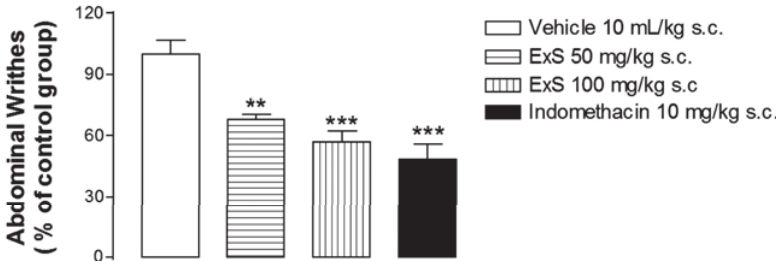
Figure 1 - Effect of Streptoverticillium sp. extract (ExS 50 and 100 mg/kg, s.c.) on the number of acetic acid-induced abdominal writhes in mice. The vertical bars indicate the mean ± SEM, expressed in relative percentage to the control group. Indomethacin (10 mg/ kg, s.c.) was used as a positive control. ** p < 0.01, *** p < 0.001, vs control group (vehicle). T AIL F LICK T